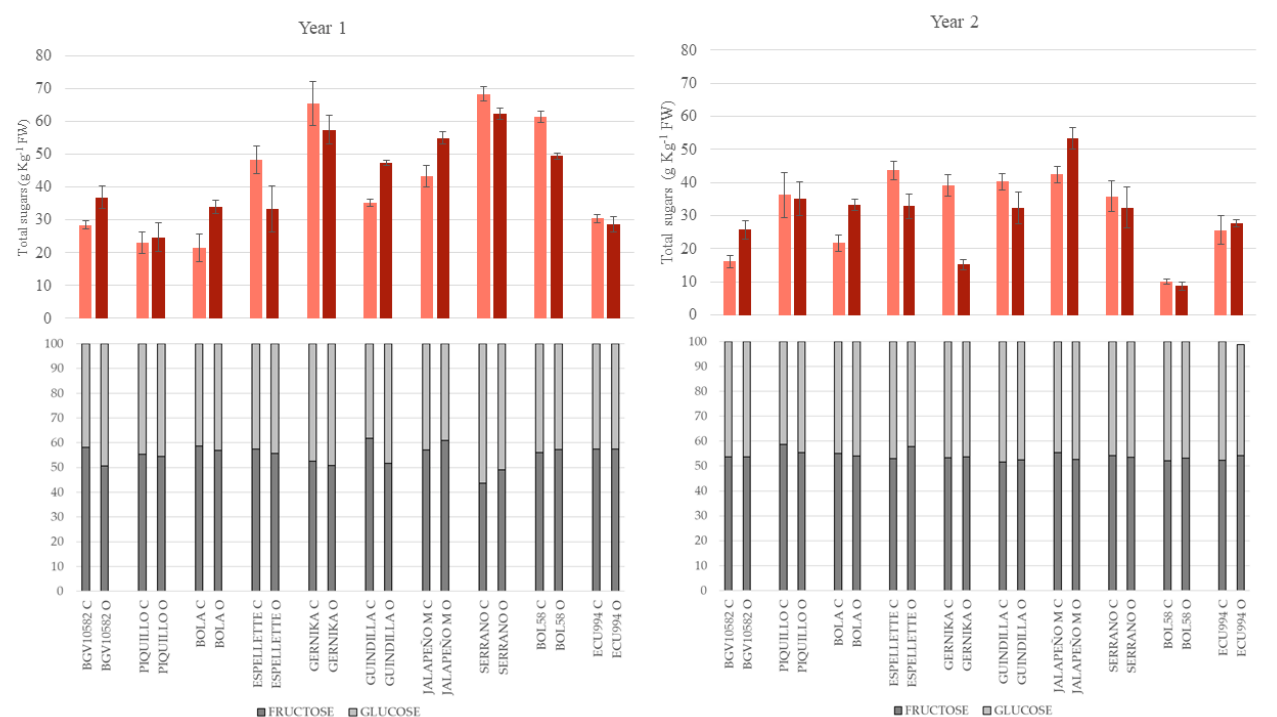
Figure 2. Content of total sugars (upper, g kg − 1 fresh weight) and sugar profile (lower, % of total sugars, grey = fructose, and pale grey = glucose) at the fully ripe stage for the accessions evaluated under conventional (pale red or C) and organic (red or O) growing conditions in years 1 and 2. Vertical bars in the upper figures indicate SE intervals for each mean value.